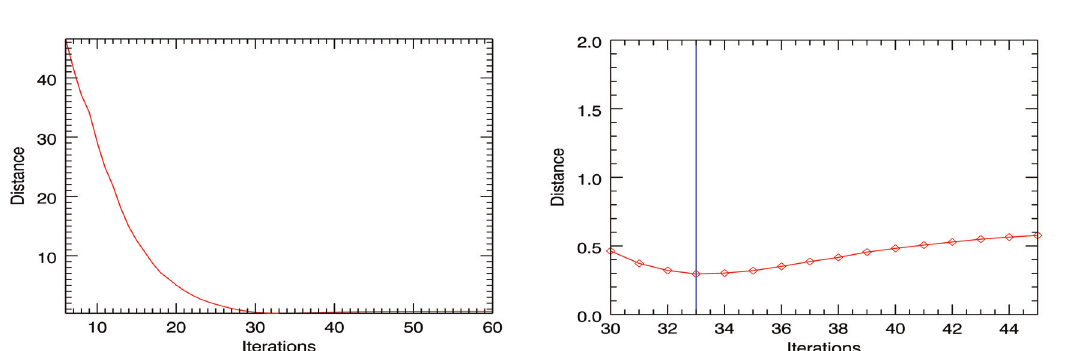
Figure 8: A comparison of the Euclidean distance between the parameter uncertainties returned by CURVEFIT and those of PSFIT as a function of the iteration limit. The same image was fit each time. The distance was used as a convergence of the uncertainties would be reflected as a decrease of the distance when the parameter uncer- tainties are treated as a point in a six-dimensional space. On the left, the full plot show the rapid convergence of the swarm with iteration limit. On the right, a close up of the region near the minimum shows a slight increase in the distance after 33 iterations (blue line) possibly due to the zig-zag effect as mentioned in the